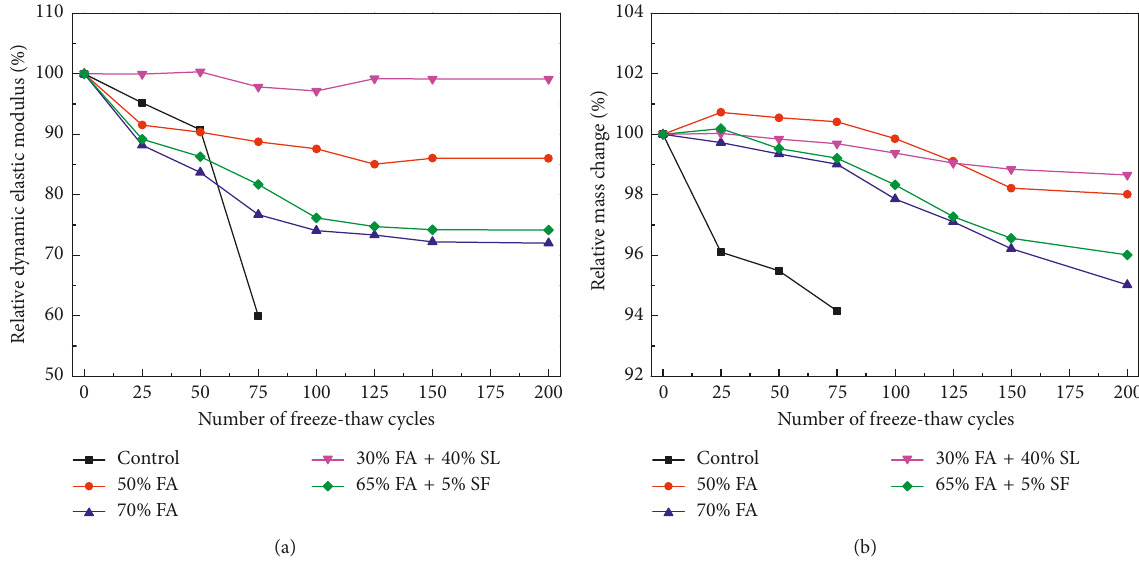
Figure 3: (a) Relative dynamic elastic modulus. (b) Relative mass change under freeze-thaw cycles in sodium chloride